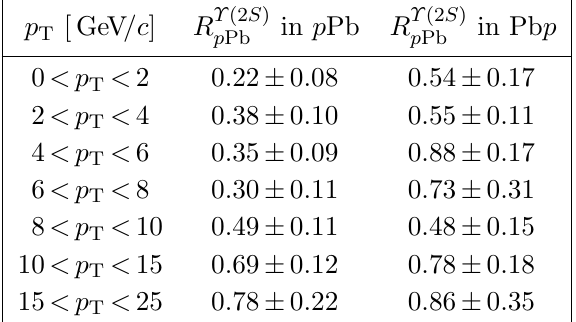
, in p Pb and Pb p as a function of p T integrated p Pb